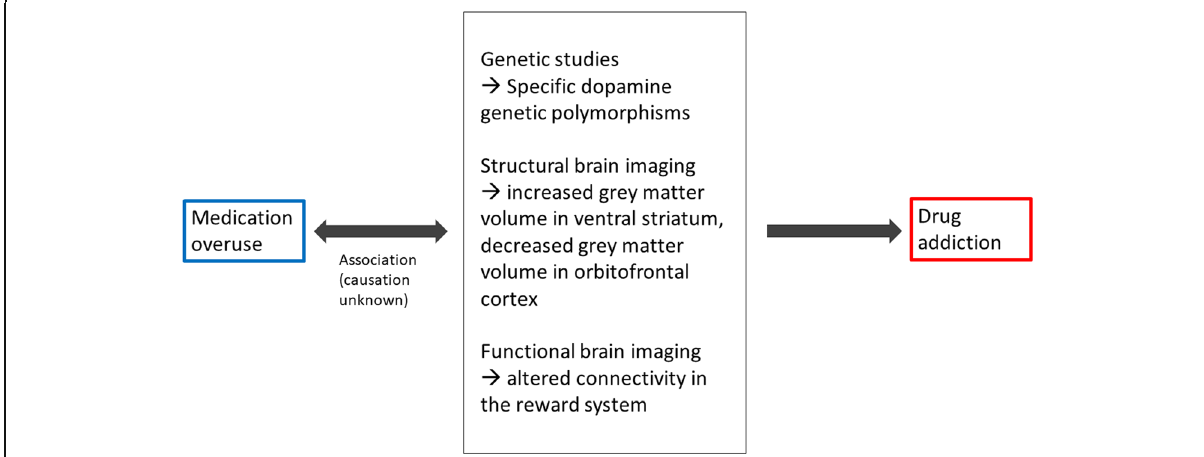
Fig. 3 Simplified neuroimaging findings that overlap for MO and drug